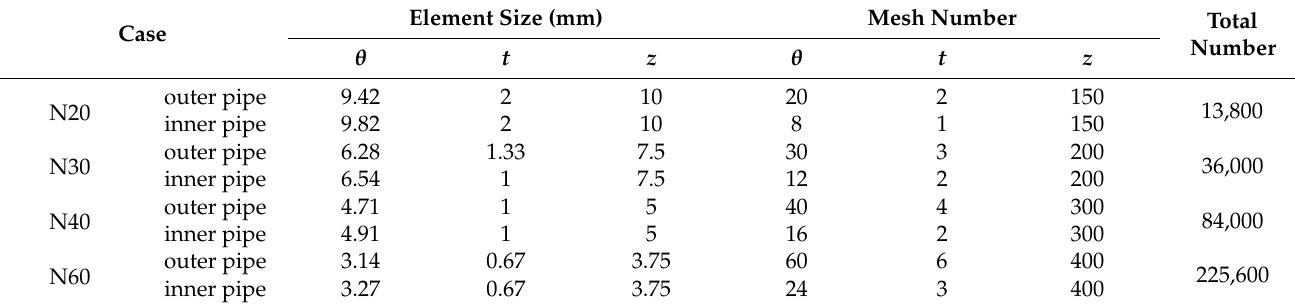
Table 2. Detail mesh division of N-series.